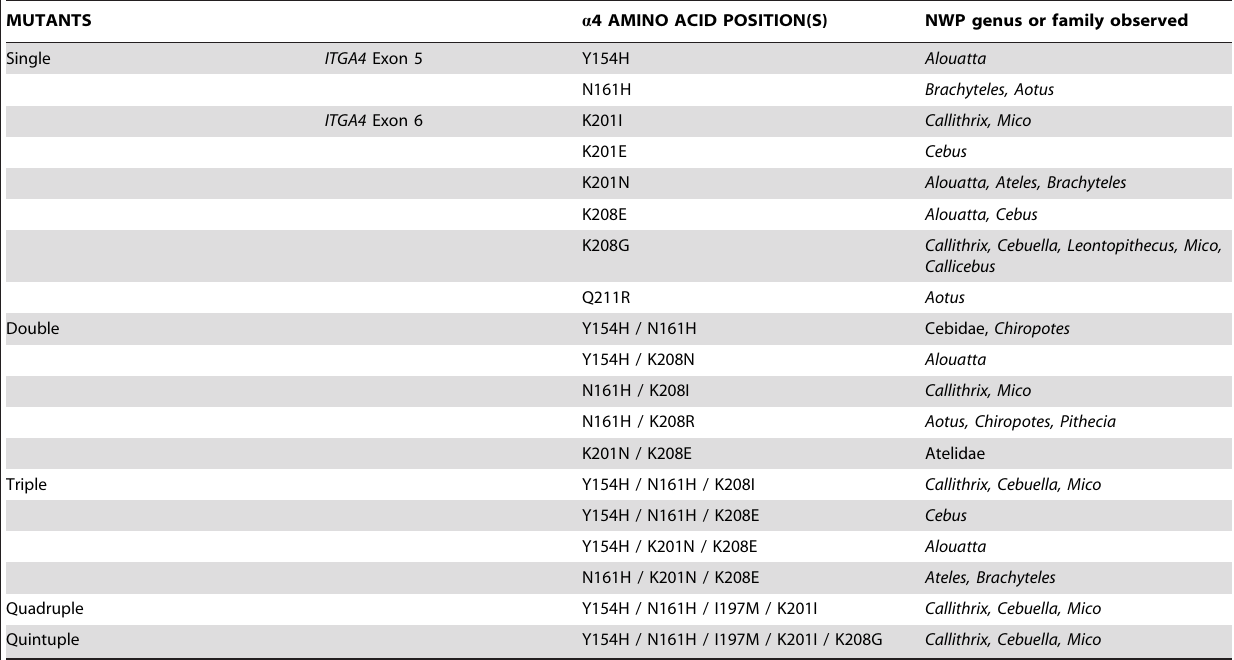
Table 2. Single and multiple a 4 mutants generated in this study.